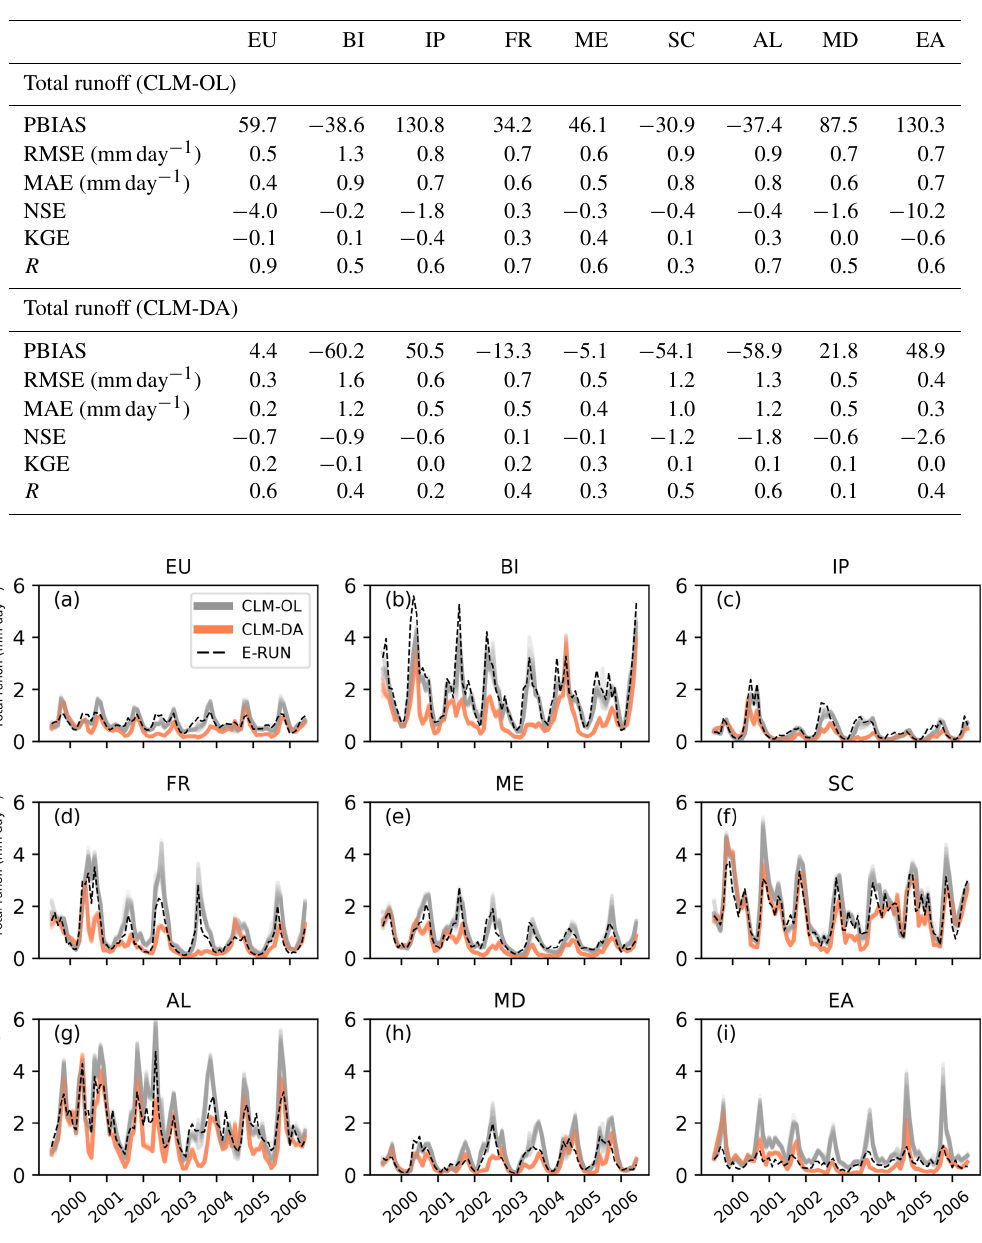
Figure 9. Monthly time series of runoff from CLM-DA and CLM-OL simulation and compared with E-RUN runoff observation data for the years 2000–2006 over Europe and PRUDENCE regions. The orange and grey lines are the CLM-DA and CLM-OL for 20 ensemble members,